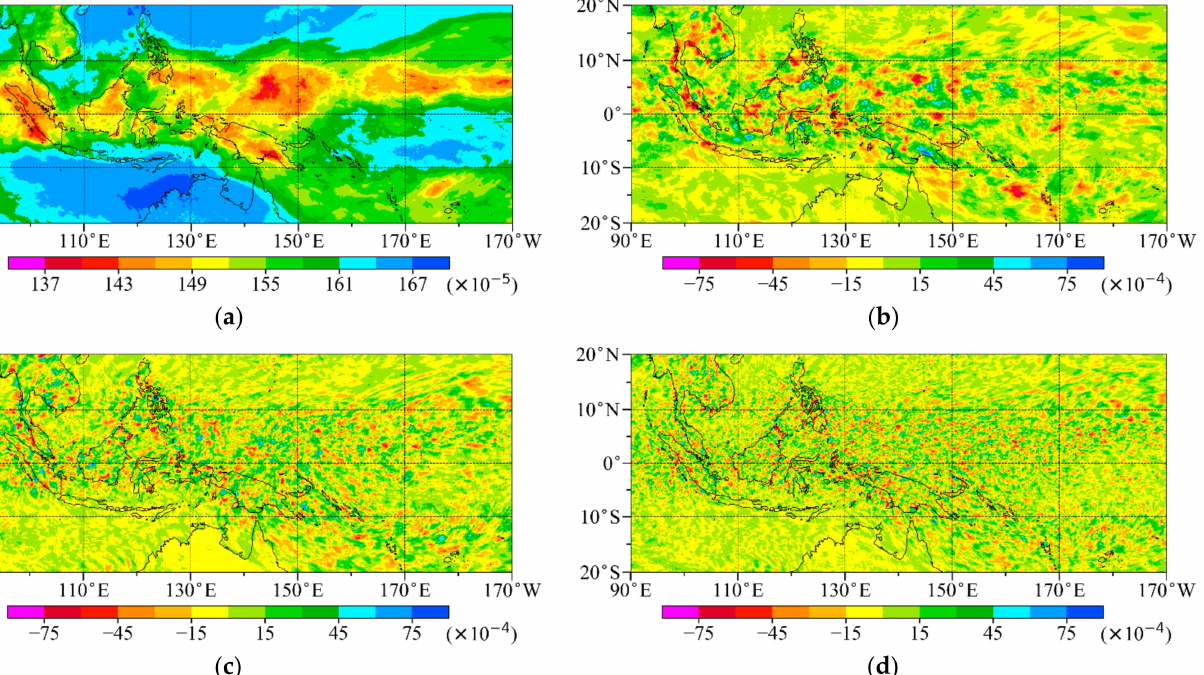
→ → → → u 1 , u 20 , u 40 , and u 60 ), and their